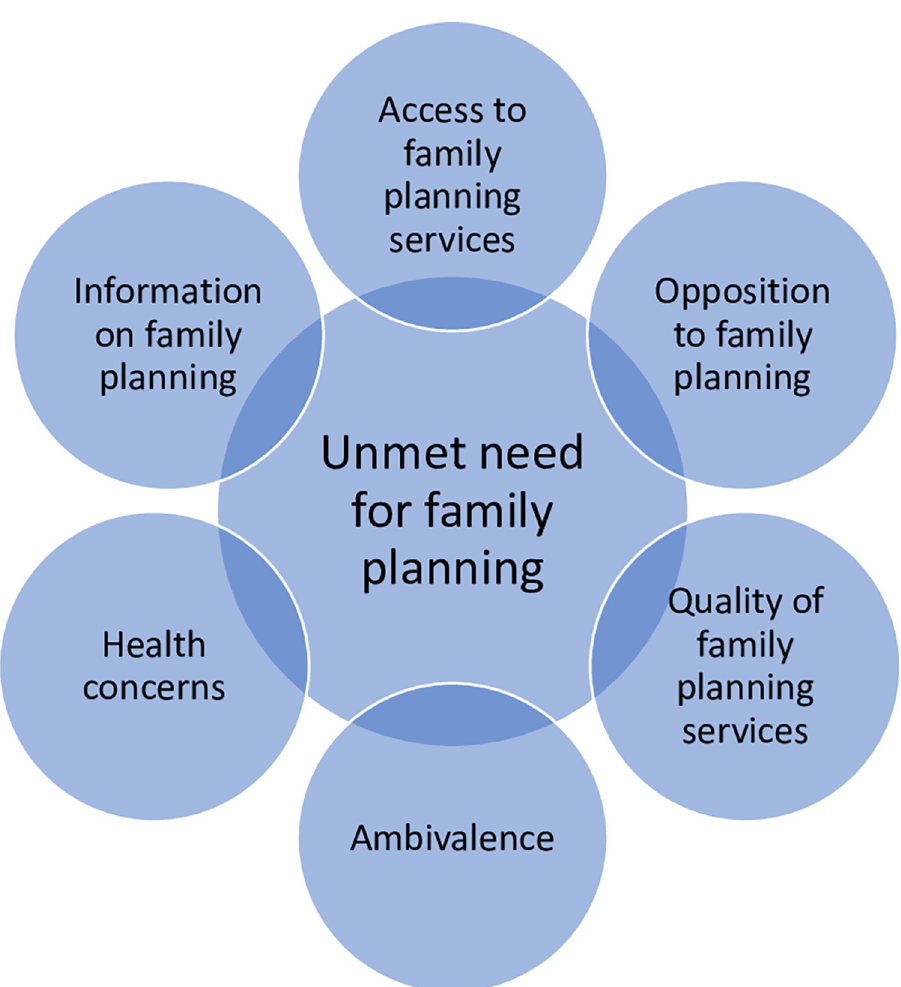
Fig 1. Analytical framework adapted from Mosley’s conceptualisation of research for unmet need for family planning [33, 34].